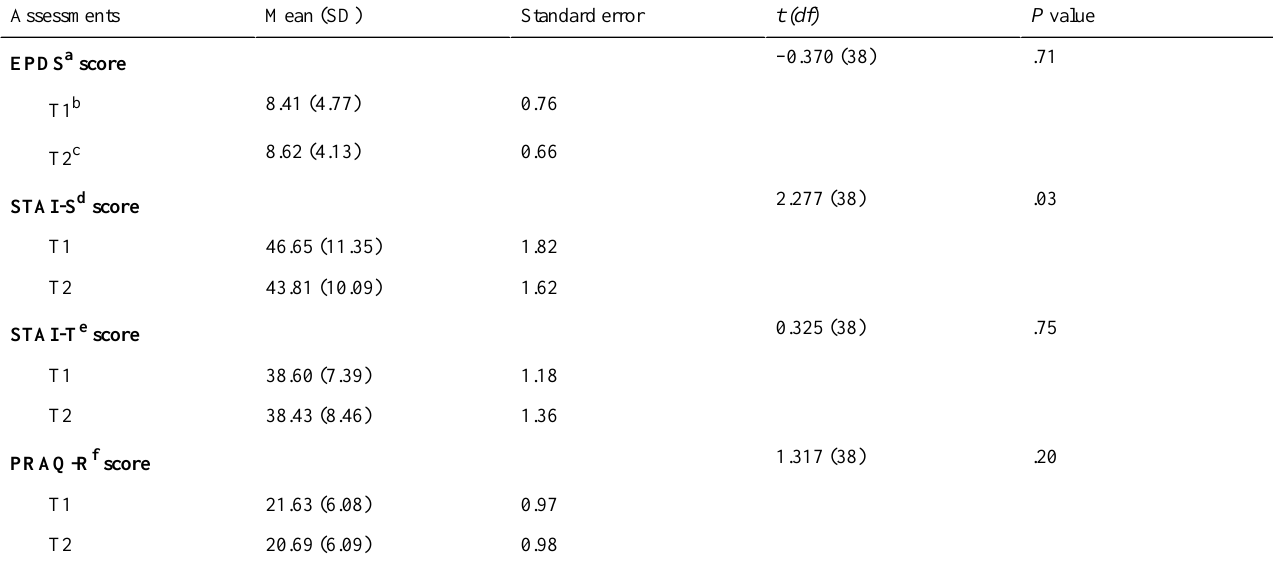
Table 7. Results of the paired sample t tests on the changes between the first and second assessments (n=39).